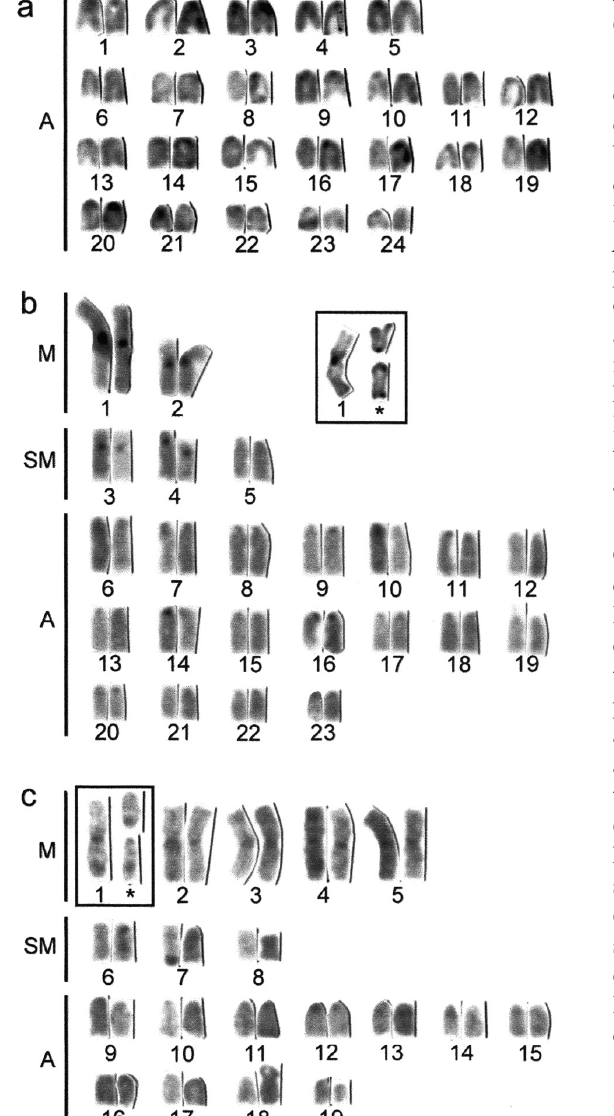
detected by FISH in the telomeric region of two large acrocentric chromosomal pairs in C. insolata (Figure 3e) and in the pericentromeric region of two large metacentric chromosomes, comparable to pairs 2 and 3, of C.